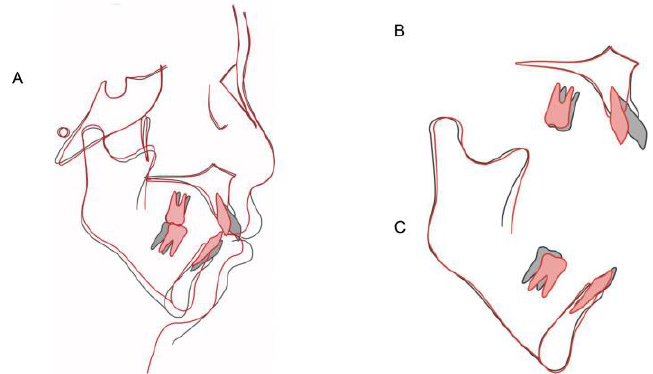
Figure 10. Cephalometric superimpositions of pretreatment (black) and post-treatment (red): ( A ) SN plane; ( B ) maxillary plane; ( C ) mandibular plane.